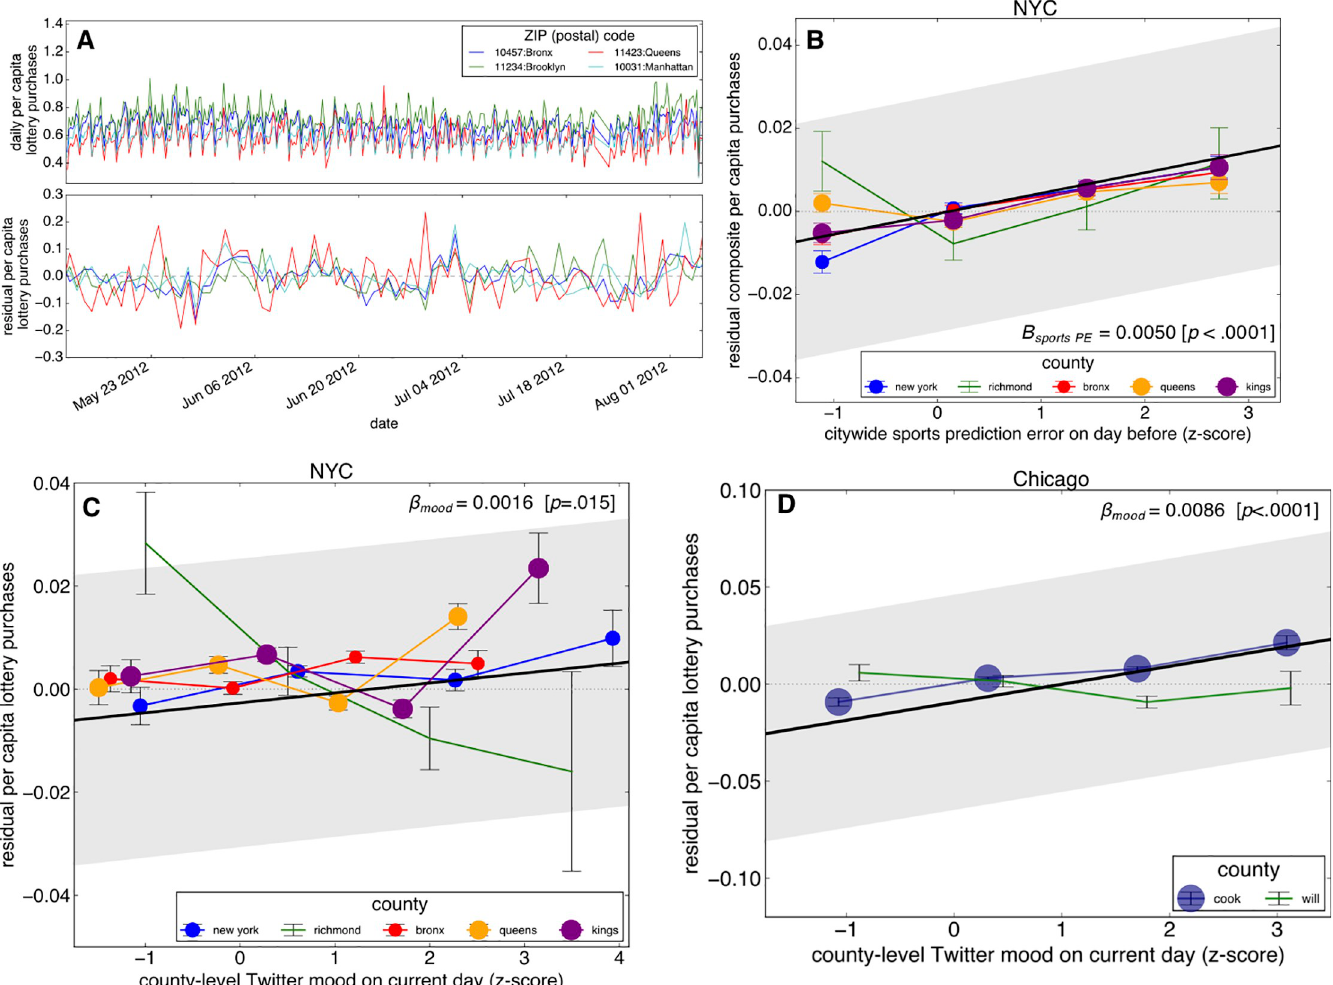
Fig 3. Prediction errors, lottery gambling, and twitter-inferred mood. (A) The composite per-capita purchases of daily lottery gambling in NYC exhibits substantial day-to-day variability in 2012. After controlling for nuisance variables, we still find prominent fluctuations in gambling apparently correlated at the neighborhood-level. (B) Positive citywide sports prediction errors (horizontal axis) predict increasing per-person gambling levels (plotted as residuals, after controlling for a number of nuisance variables, along the vertical axis) in NYC. (C and D) Twitter-inferred mood significantly and positively predicts per-person lottery gambling rates on the same day in the NYC and Chicago MSAs. The population of each county included in the MSA-level regression models are represented by point size. MSA-level regression lines are depicted in black. All data plotted in this figure are from the confirmatory datasets (the year 2013).